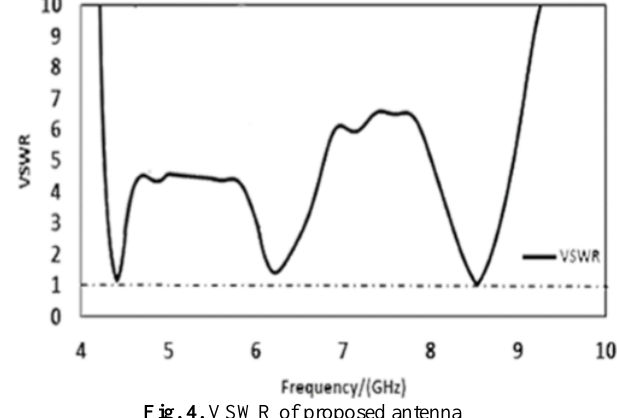
Fig. 4. VSWR of proposed antenna